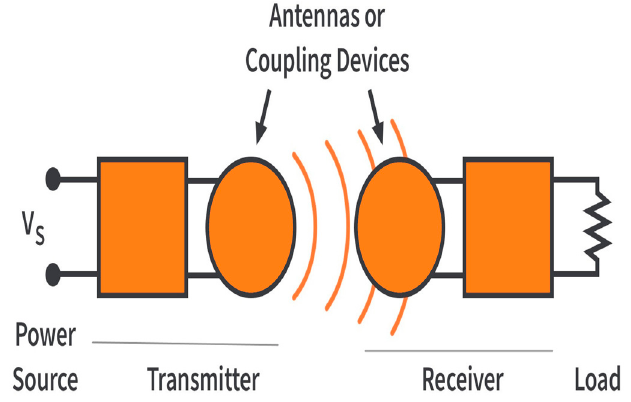
Figure 14. Microwave power transmission.